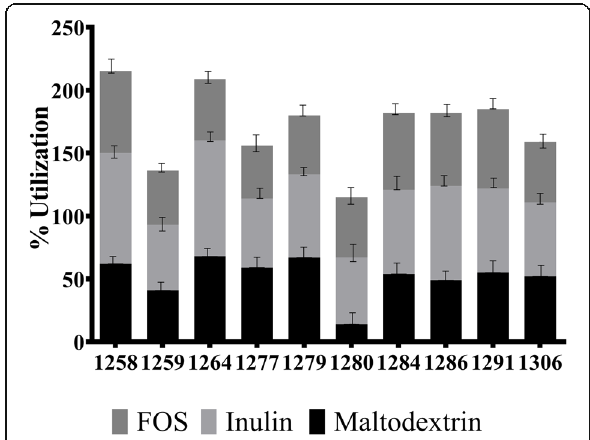
Fig. 2 Prebiotic utilization by LAB strains during growth. 1258: L. plantarum , 1259: L. plantarum, 1264: P. pentosaceus , 1277: L. plantarum , 1280: L. plantarum , 1284: L. plantarum, 1286: L. plantarum, 1291: P. pentosaceus , 1301: L. plantarum . Results are means of three independent experiments with three repetitions ± SD, n = 3